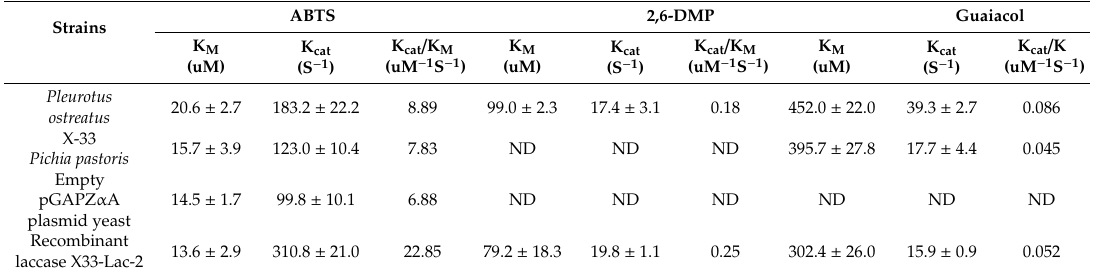
Table 2. Kinetic parameters of each strain.